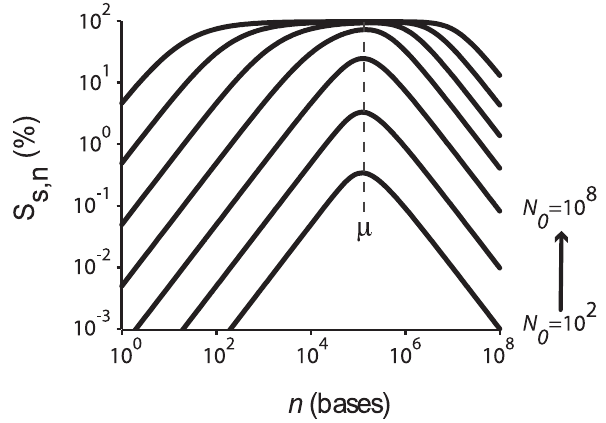
Figure 5. Overall splicing efficiency S s,n as a function of the transcript length n as defined in Eq. 13. The parameters are N 0 (10 2 , 10 3 , 10 4 , 10 5 , 10 6 , 10 7 and 10 8 molecules from bottom to top), k off , (cid:2) nn ~ 10 s 2 1 , x d ~ 8 | 10 5 bases 2 s 2 1 , k E =72 bases 1 s 2 1 and t t ~ 10 9 bases 1 s 1 . At low N 0 , the splicing efficiency curve shows a maximum ( m ) at a transcript length of n * 1 : 25 | 10 5 bases, corresponding to e ~ h { 1 n ð Þ & 32 + 5 exons. As N 0 increases, the splicing efficiency will be almost . 95% in the range of n values from 10 2 to 10 6